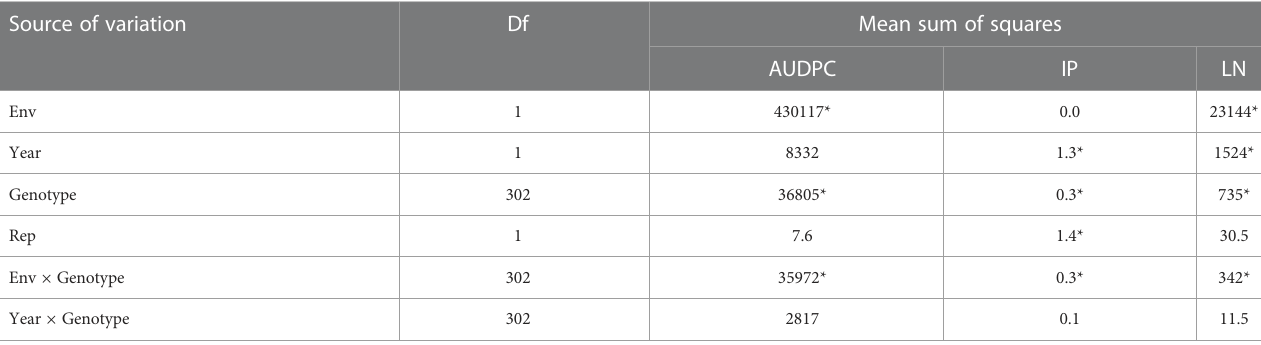
TABLE 1 ANOVA for three traits: (i) area under disease progress curve (AUDPC), (ii) incubation period (IP) and (iii) lesion number (LN). Source of variation Df